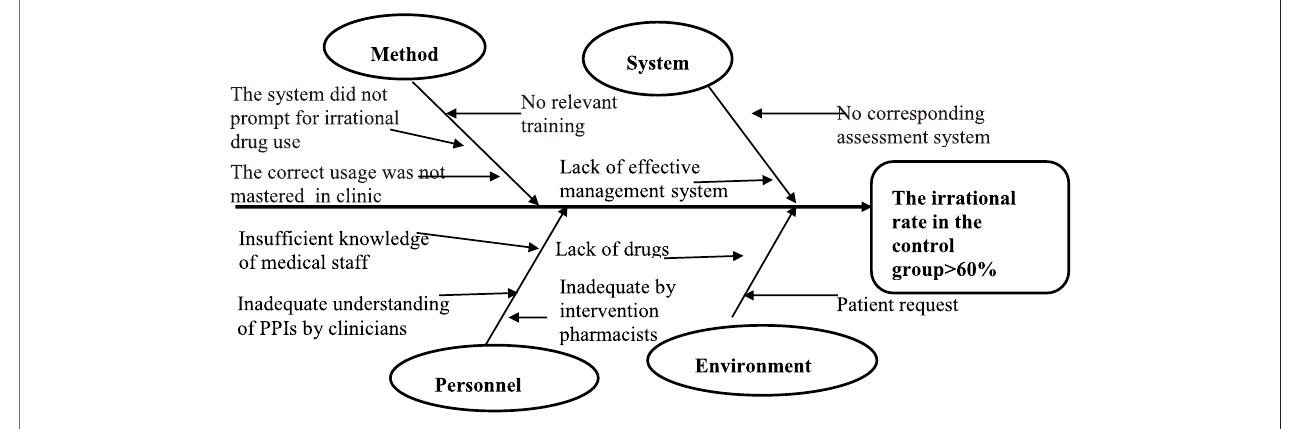
FIGURE 4 | Fishbone diagram analysis for irrational PPI use in the control group.